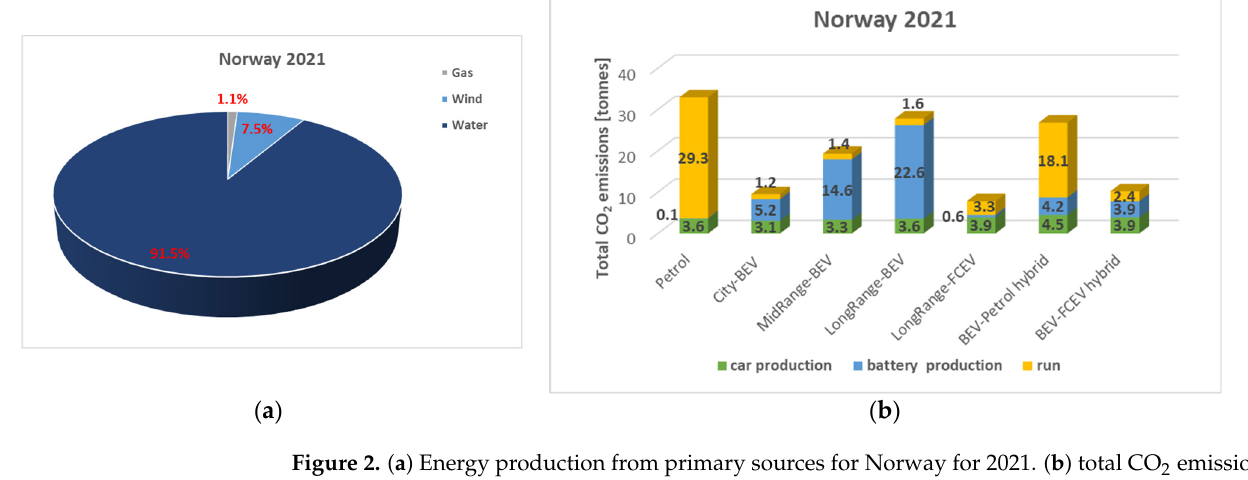
Figure 2. ( a ) Energy production from primary sources for Norway for 2021. ( b ) total CO 2 emissions for 2021 for Norway for different types of cars, including car and battery production, as well as running of the vehicle considering different sources for energy production .